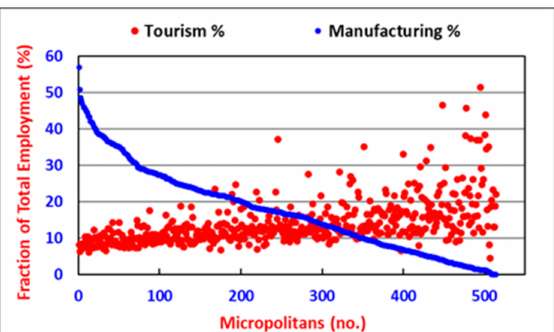
Figure 15. Employment strengths (% of total) of the micropolitans, compared with ranked manufac- turing sector strengths (% of